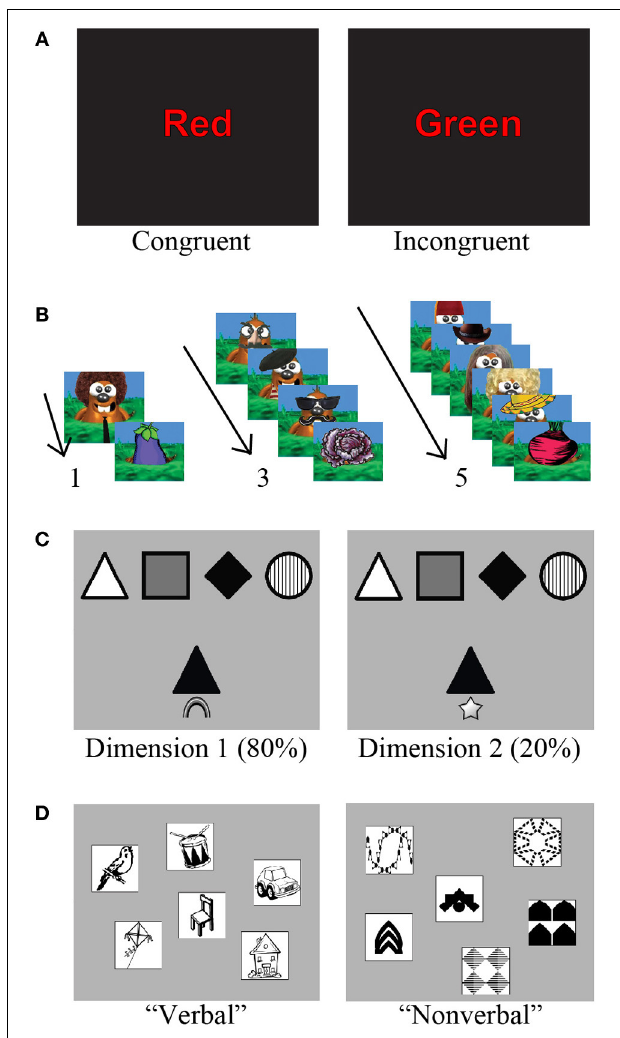
FIGURE 1 | Examples of the cognitive control battery. (A) For the Stroop task, participants had to respond by indicating the ink color on congruent (left) or incongruent (right) trials. (B) “Whack-a-mole” Go/No-Go task. Children were instructed to press a button as quickly as possible when a cartoon mole appeared (Go trial), but to avoid pressing the button when a vegetable appeared (No-Go trial). No-Go trials were preceded by 1, 3, or 5 Go trials (Adapted from Shapiro et al., 2013). (C) The two gray squares each represent a touch-screen display in the Visually-Cued Card Sort (VCCS). A sample of the target cards can be seen at the top of the screen, while the test card is below. The visual cue appears just below the test card, with a rainbow indicating to sort by color (left panel), and a star indicating to sort by shape (right panel). (D) The two gray squares each represent a touch-screen display in the for the verbal and non-verbal Self-Ordered Pointing Test (SOPT), respectively. Images represent a trial with 6 objects, the most difficult condition of the